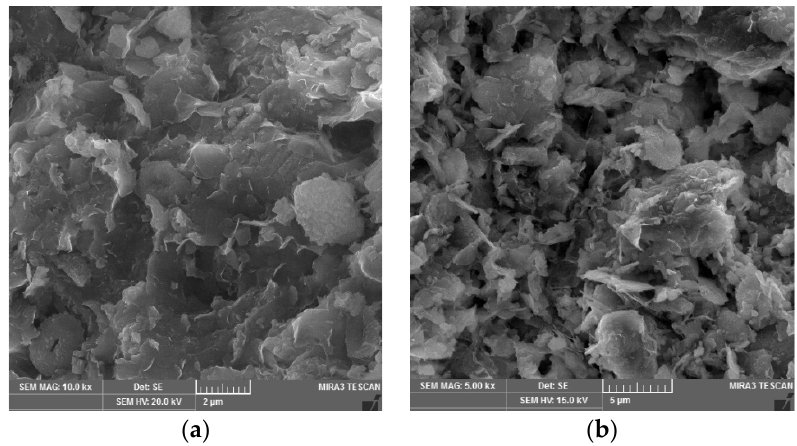
Figure 7. ( a ) SEM image of the self-compacting grout based on clay soil Cl, 4% CEM and 0.1% SC, ( b ) SEM image of the self-compacting grout based on clay soil Cl, 4% CEM, 10% FBCA, and 0.1% SC.